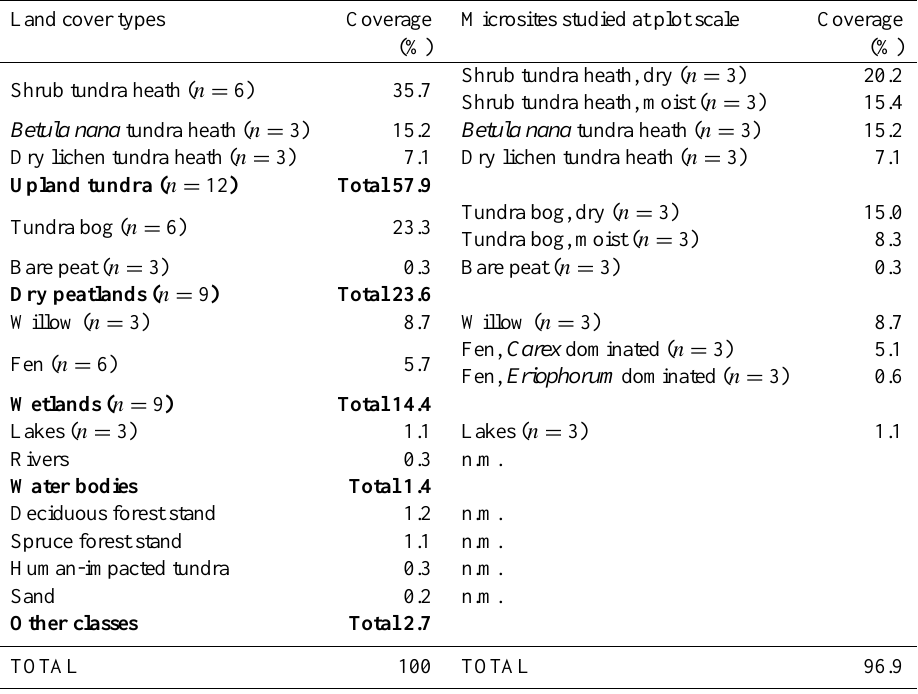
Table 2. Coverage of different land cover types in the study region and their correspondence to microsites measured at plot scale (chamber, snow gradient and lake measurements). The percent coverage of each land cover type and microsite is shown for the 98.6km 2 QuickBird